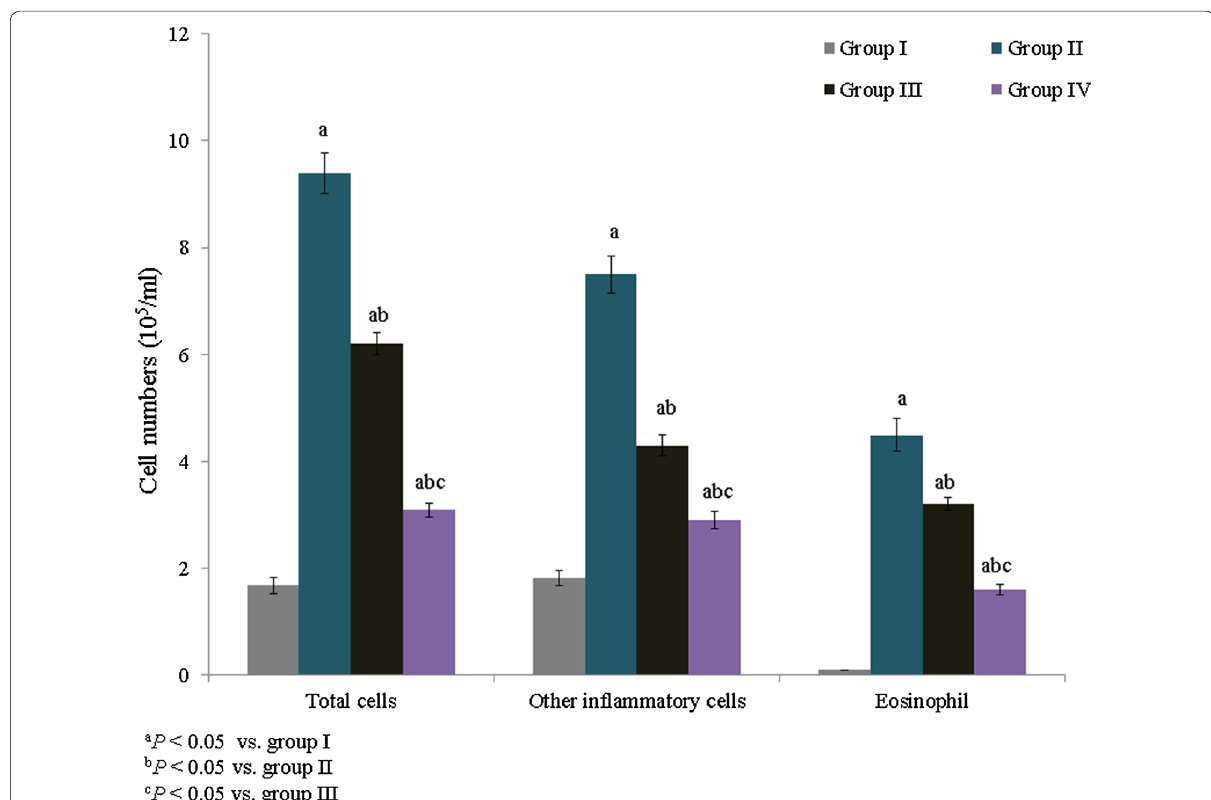
Fig. 1 Effect of E. hirta extract on inflammatory cell recruitment in the bronchoalveolar lavage fluid (BALF) of neonatal asthmatic rats. Experimental data are given as the mean standard error of the mean (SEM) ±